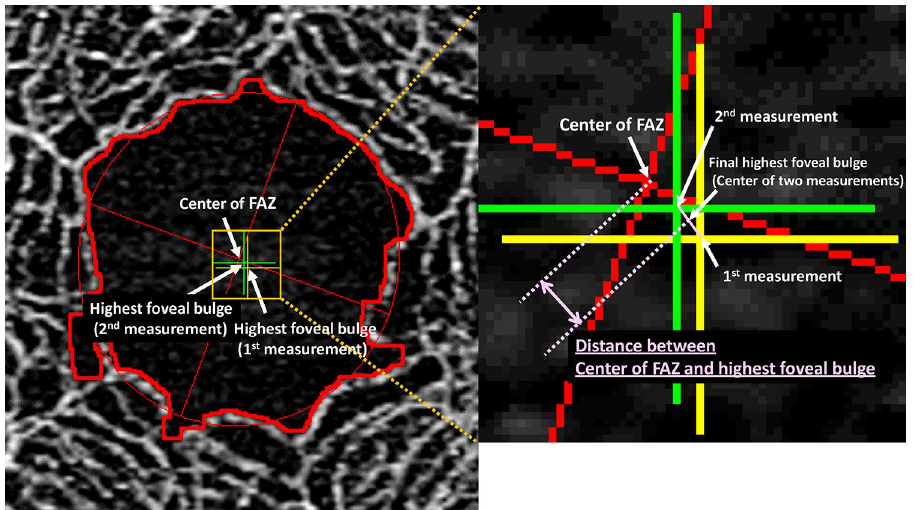
Figure 3. Schematic explanation of the distance between the center of the foveal avascular zone and the highest foveal bulge point. The red cross shows the center of the foveal avascular zone (FAZ) on the optical coherence tomography angiography (OCTA) image. The green and yellow crosses show the highest foveal bulge (FB) points that were measured manually using a B-scan image. The final highest FB point is defined as the center of the two measured highest FB points. The distance between the center of the FAZ and the highest FB point is measured (pink arrow). This figure was created using SS-OCTA (PlexElite9000 Carl Zeiss Meditec, Jena, Germany) and ImageJ software.